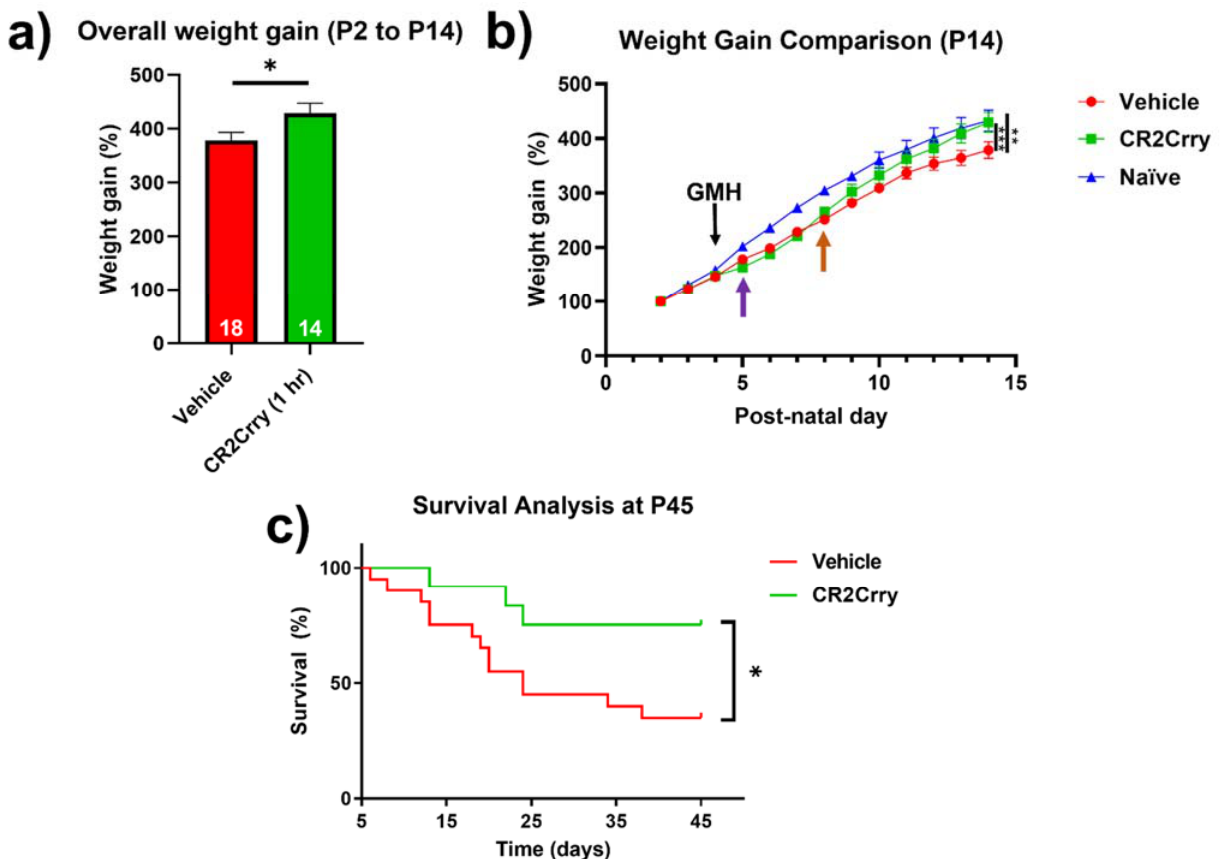
Figure 8. CR2Crry treatment improves weight gain after GMH and promotes survival. ( a ) The overall percent weight gain from day P2 to P14 in vehicle and CR2rry-treated mice. Unpaired Student’s t -test. * p < 0.05. Error bars = mean ± SEM. ( b ) Daily weight percent gain over a 12-day period following GMH induction. Deceleration in percent daily weight gain in CR2Crry and vehicle animals at P5 (purple arrow). Acceleration of weight gain in CR2Crry-treated animals (orange arrow). Two-way ANOVA with Bonferroni’s correction for multiple comparisons. ** p < 0.01, *** p < 0.001. n = 11 for naïve, n = 18 for vehicle, and n = 14 for CR2Crry. Error bars = mean ± SEM. ( c ) Survival assessed over 41 days after injury (P45). Animal survival was assessed beginning at one day after injury (P5). Animals that died within 24 h of injury were excluded from analysis. CR2Crry group deaths plateau around P25, while vehicle animal deaths continue until close to P45. P45 animal survival was 75% in the CR2Crry group compared to 45% in the vehicle ( p < 0.05). Log-rank (Mantel–Cox) test. * p < 0.05. n = 20 for vehicle and n = 12 for CR2Crry. Error bars = mean ± SEM.